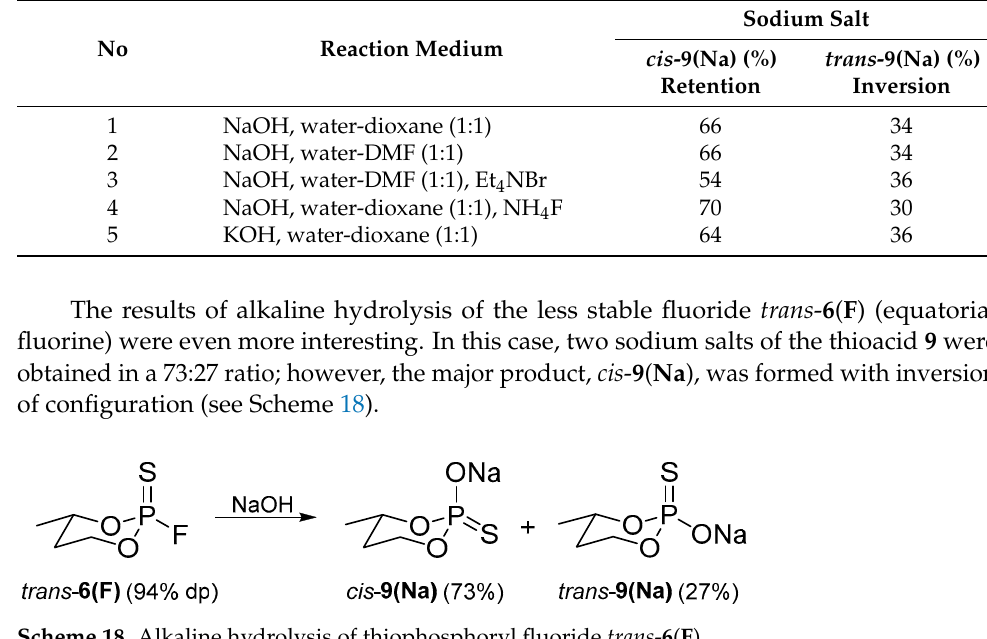
Table 2. Effect of reaction medium on percentage of cis - and trans -isomers of thioacid 9 obtained in hydrolysis of thiophosphoryl fluoride cis - 6 ( F ).